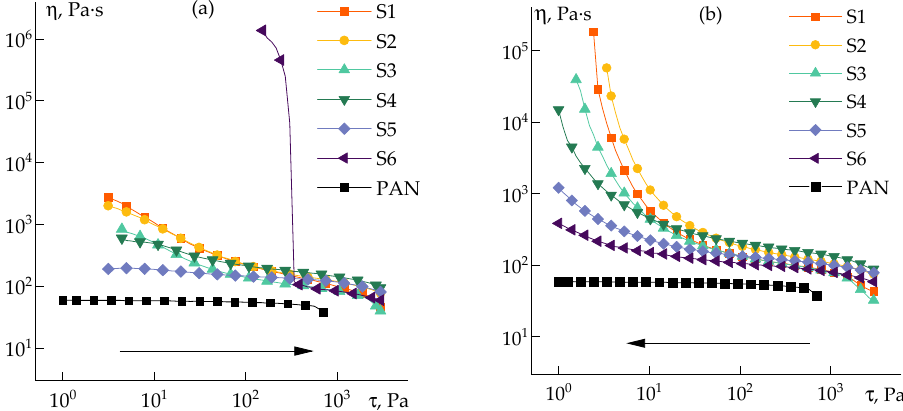
Figure 5. Flow curves of PAN solutions in DMSO containing 3 wt% of silica (at the solution weight) prepared by methods S1 − S6. Experimental procedures: ( a ) at an increase in shear rate, ( b ) at a decrease in shear rate (starting from 1000 s − 1 ).